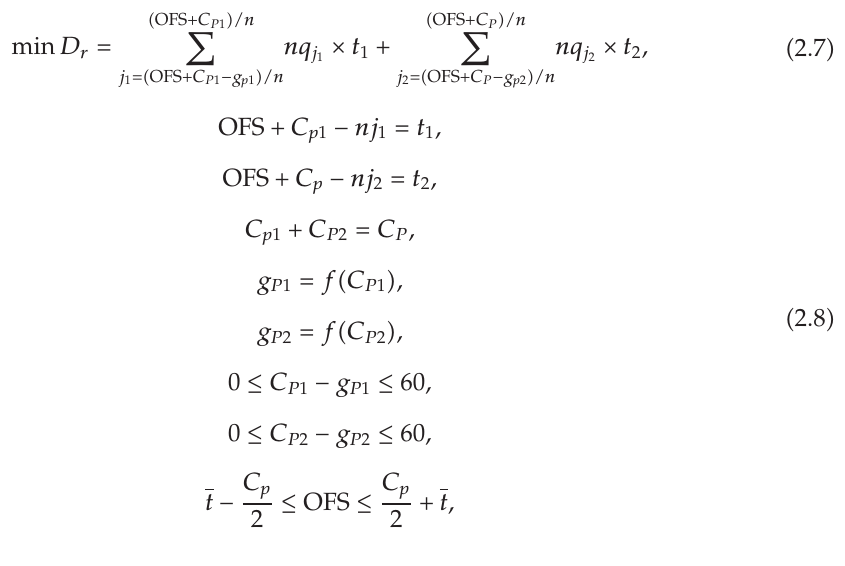
There are three unknown variables and three constraint